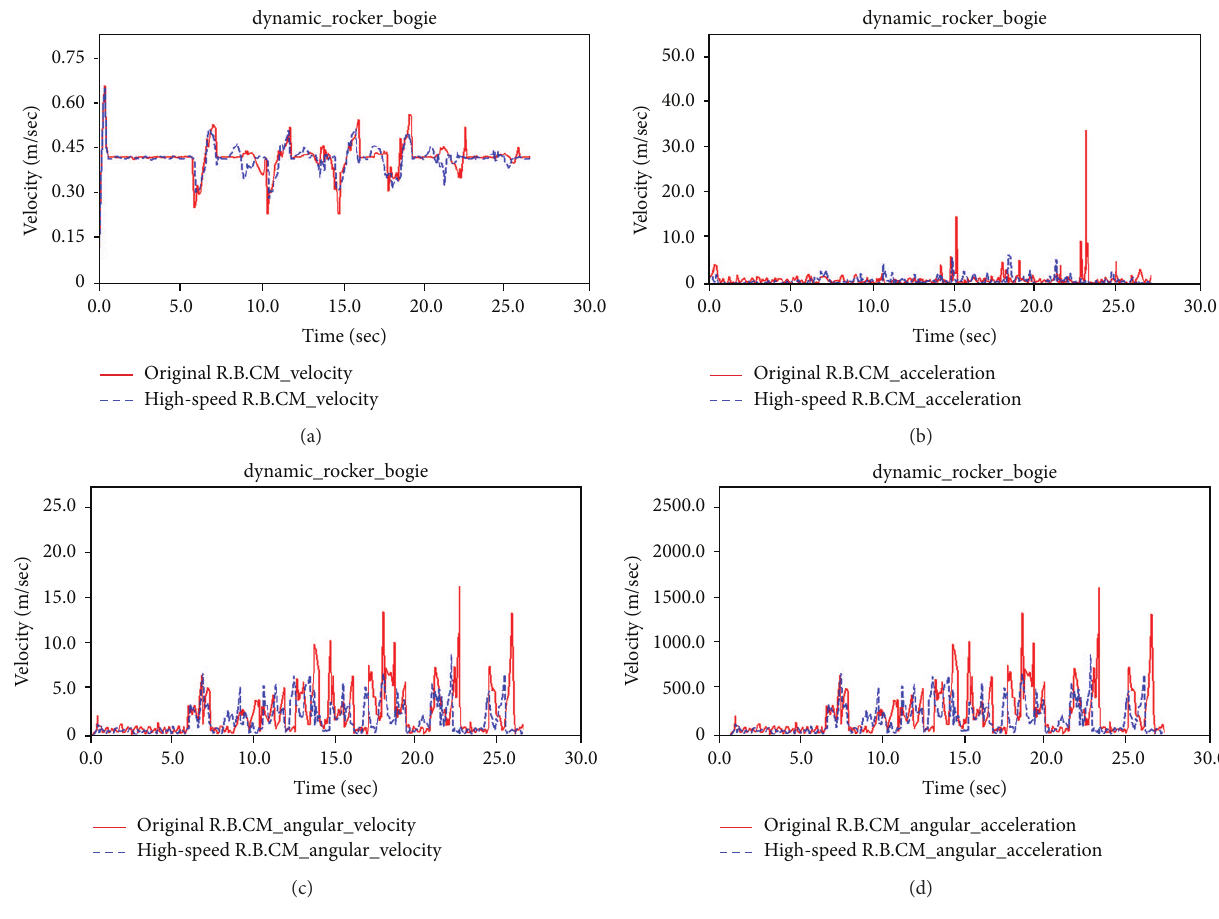
Figure 8: Velocity, acceleration, angular velocity, and angular acceleration variation of the main body: (a) velocity variation of the main body, (b) acceleration variation of the main body, (c) angular velocity variation of the main body, and (d) angular acceleration variation of the main body. Table 3: Data from yaw, pitch, and roll angular variation. Original